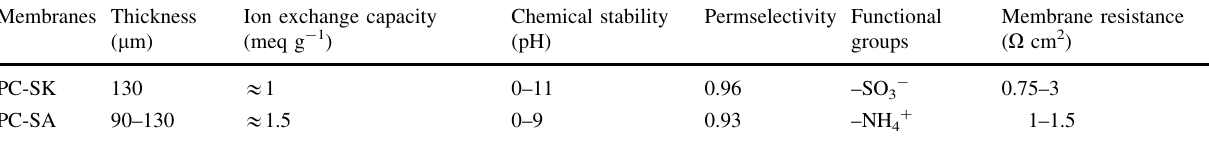
Table 2 Characteristics of the PC cell standard cation and anion exchange membranes Membranes Thickness Ion exchange capacity ( l m) (meq g - 1